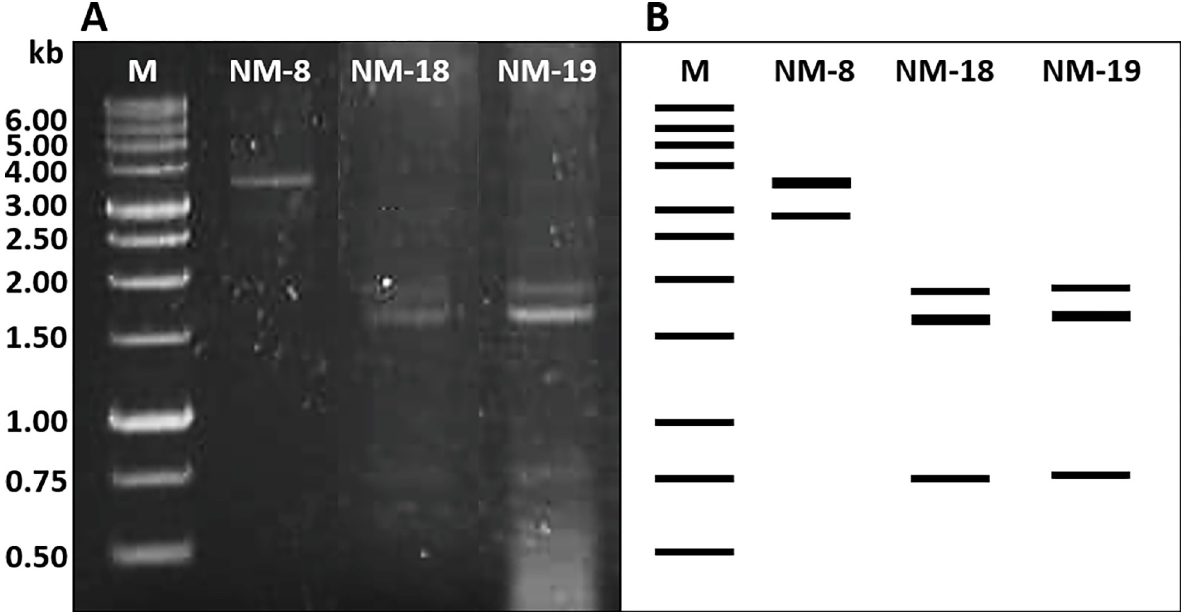
Fig 5. Two putative dsRNA patterns of the 3 mycovirus infected strains. A) Gel electrophoresis of isolated dsRNA patterns of fungal isolates. B) The dsRNA profiles displayed in